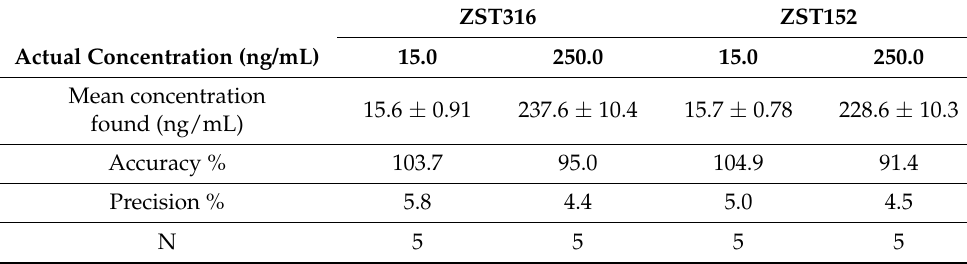
Table 2. Intra-day precision and accuracy results for ZST316 and ZST152 in